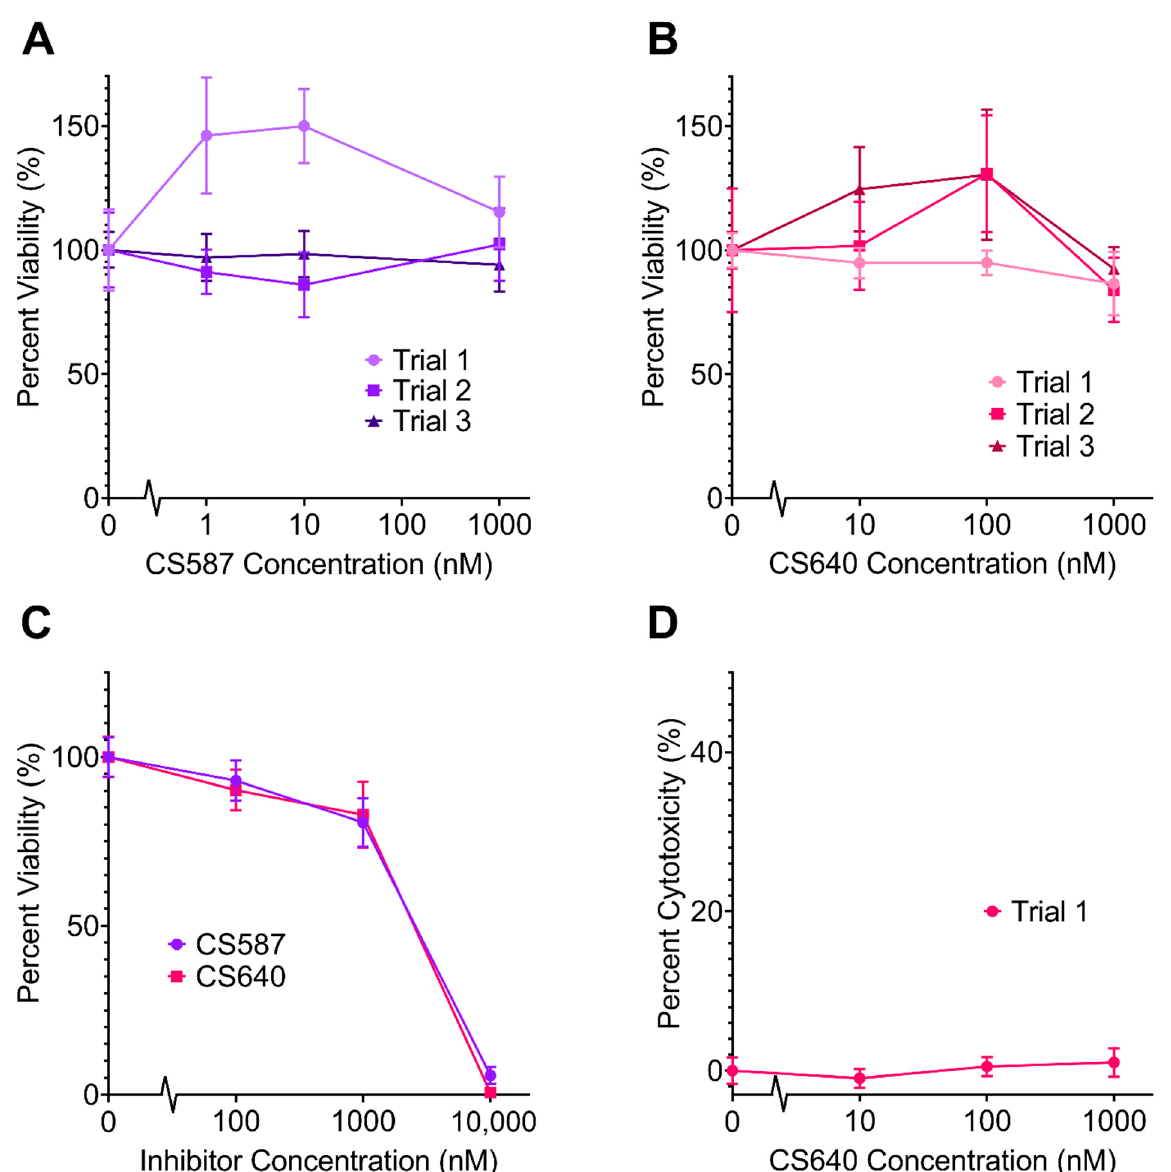
Figure 3. Effect of varying concentrations of CaMK1D inhibitors on primary neurons. Viability of mouse primary cortical neurons was measured by MTT assay. The response from cells treated with no CaMK1D inhibitors was normalized to 100% viability. Results of three separate MTT assay trials using ( A ) CS587 and ( B ) CS640. ( C ) Results of MTT assays using the inhibitors at higher concentrations, up to 10 µM. ( D ) Results of one LDH assay trial with CS640. Points represent the mean of six replicates, and error bars represent standard deviation.